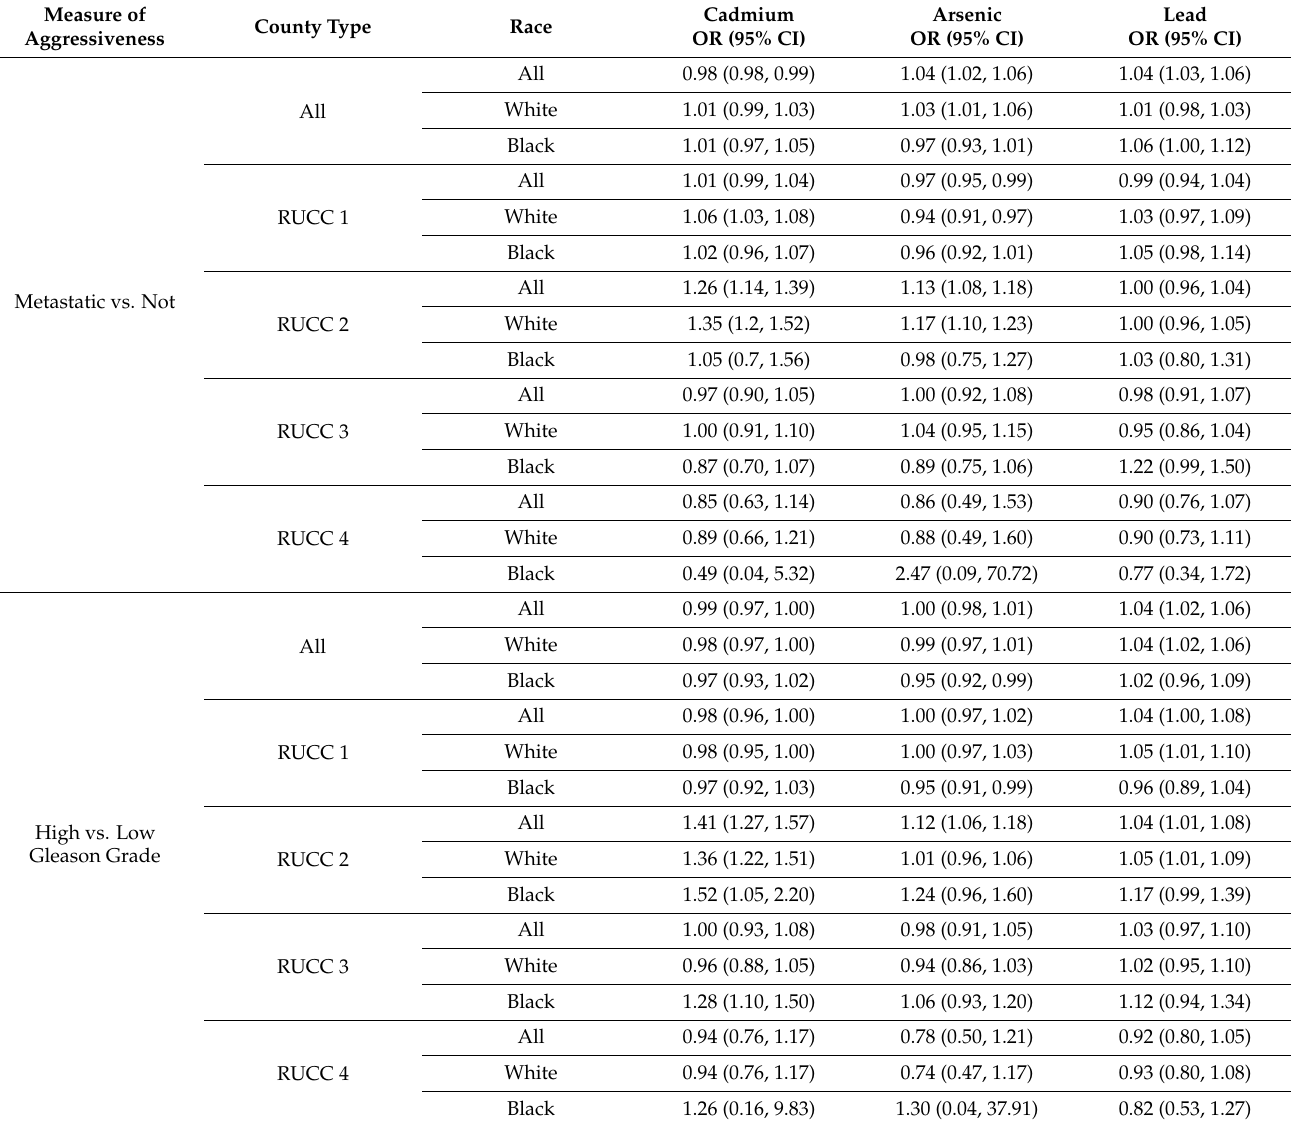
Table 3. Adjusted odds ratios and 95% confidence intervals for aggressive prostate cancer for cadmium, arsenic, and lead each as the exposure variable for cases from the 2010–2014 Surveillance, Epidemiology and End Results (SEER) database stratified by county type and race comparing the 80th percentile with the 20th percentile of exposure. Measure of County Type Race Aggressiveness